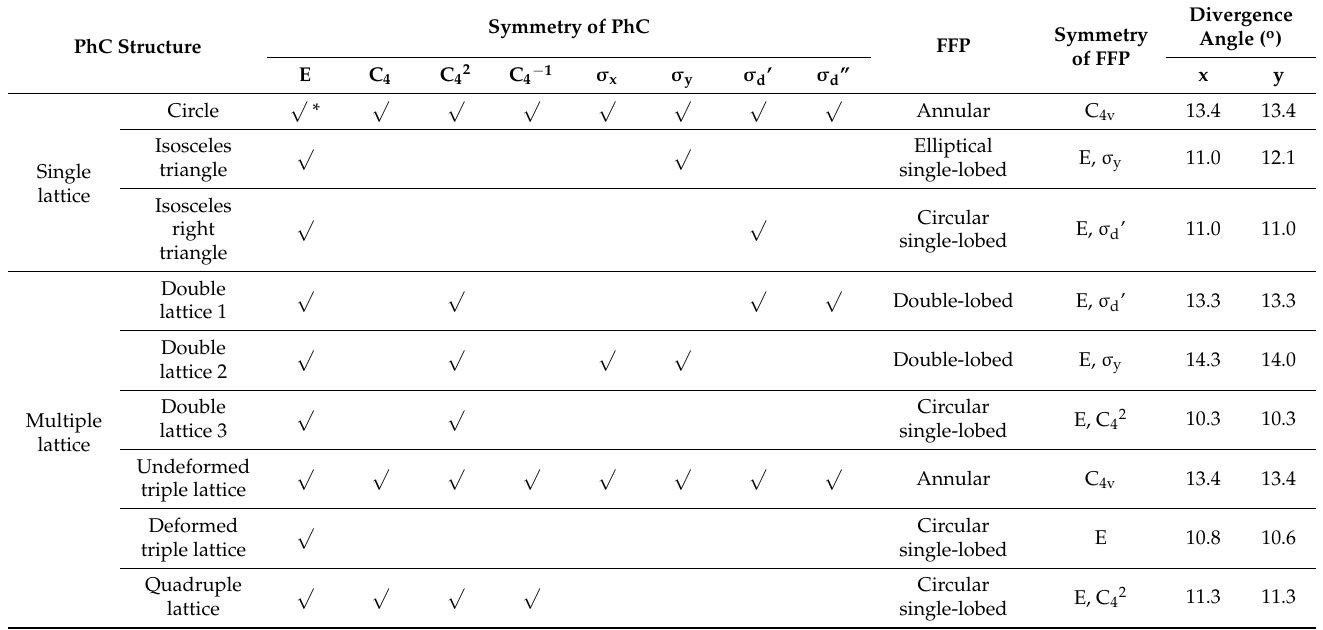
Table 1. The symmetry characteristics and far-field performance of various PhC